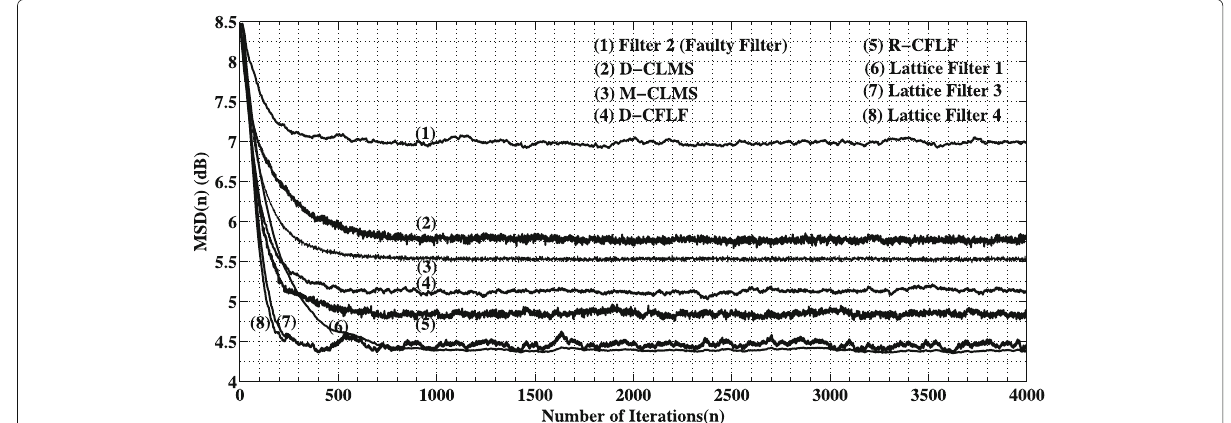
Fig. 11 MSD comparison of the proposed schemes with those of the M-CLMS and D-CLMS schemes under faulty operating conditions when input signal is white